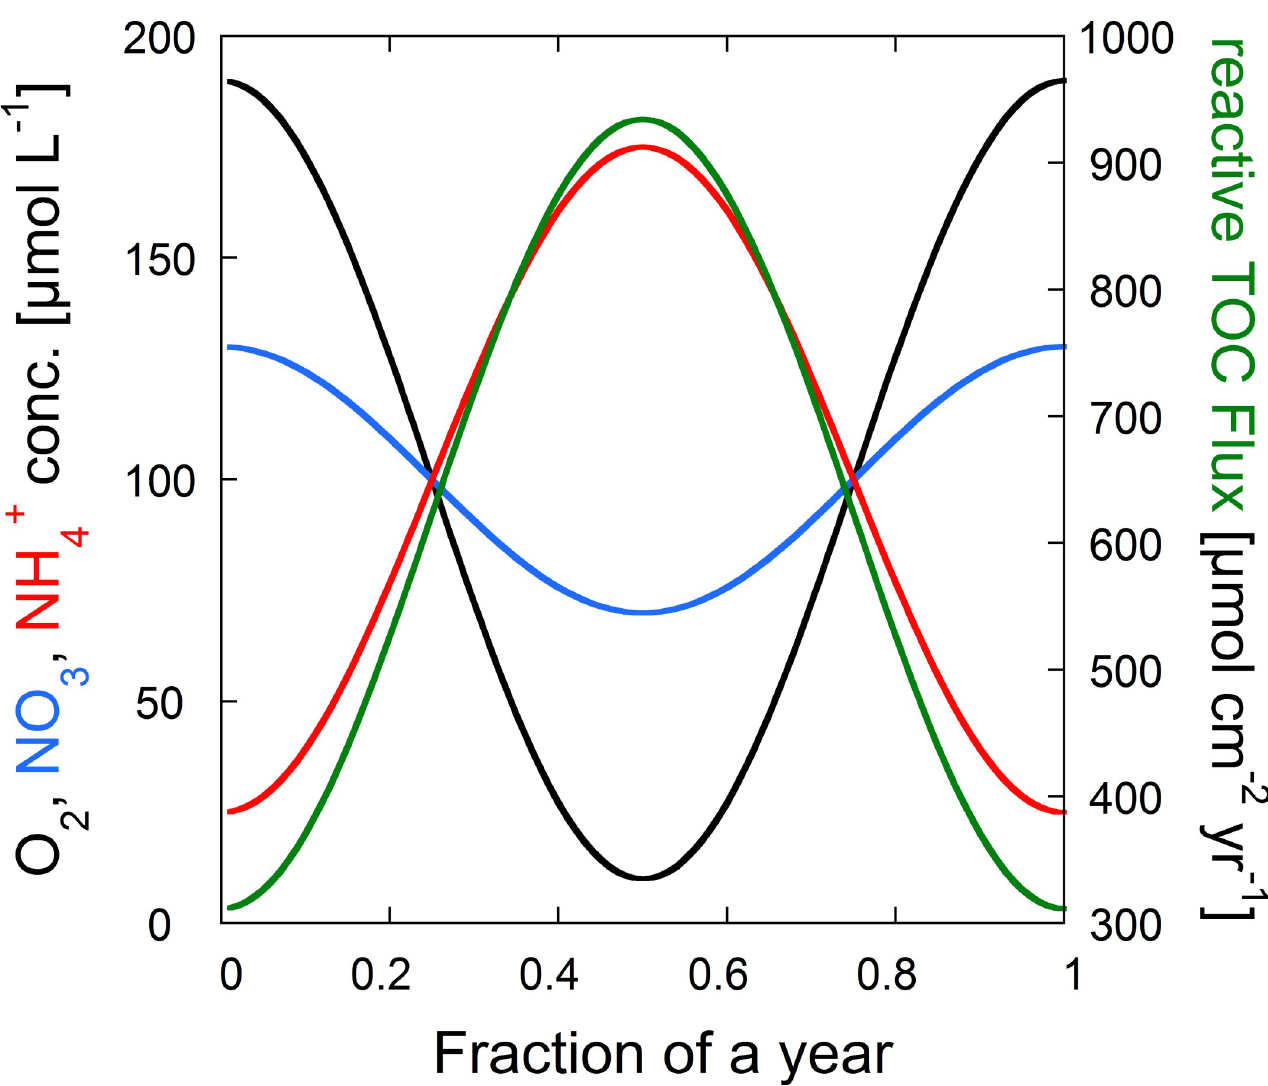
Fig 1. Simplified seasonal variations in the boundary concentrations of the “status quo” scenario shown for selected TEAs, the reactive TOC flux and NH 4+ .